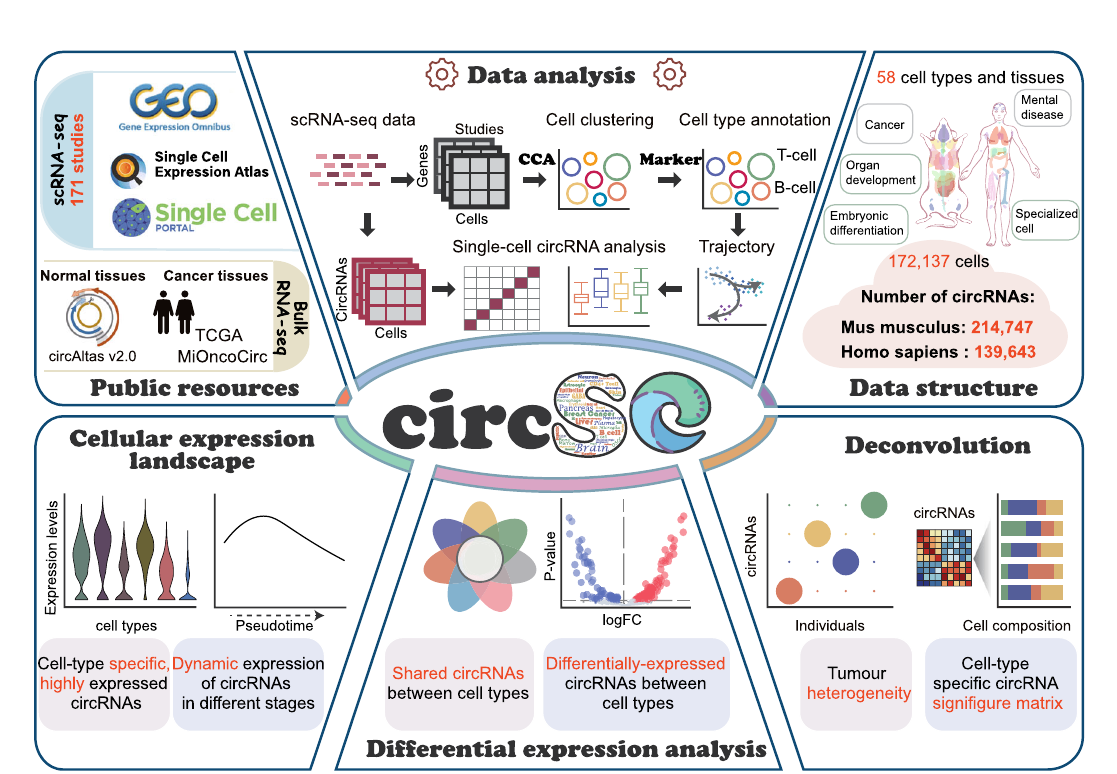
Fig. 6 The construction and functionalities of the online portal circSC. circSC consists of the cellular expression pro fi les of 354,390 circRNAs detected from 172,137 single cells, covering 58 cell types and tissues. circSC provides an intuitive interface for users to browse, search, and visualize the expression of circRNAs in various studies and cell types. It also integrates differential expression analysis between different cell types and the intra- and inter- heterogeneity of circRNAs between tumor patients. The circRNA signature matrix of tumor-in fi ltrating immune cells can be directly accessed, and users can input circRNA expression pro fi les from bulk RNA-seq data for deconvolution analysis. The anatogram is plotted using gganatogram 86